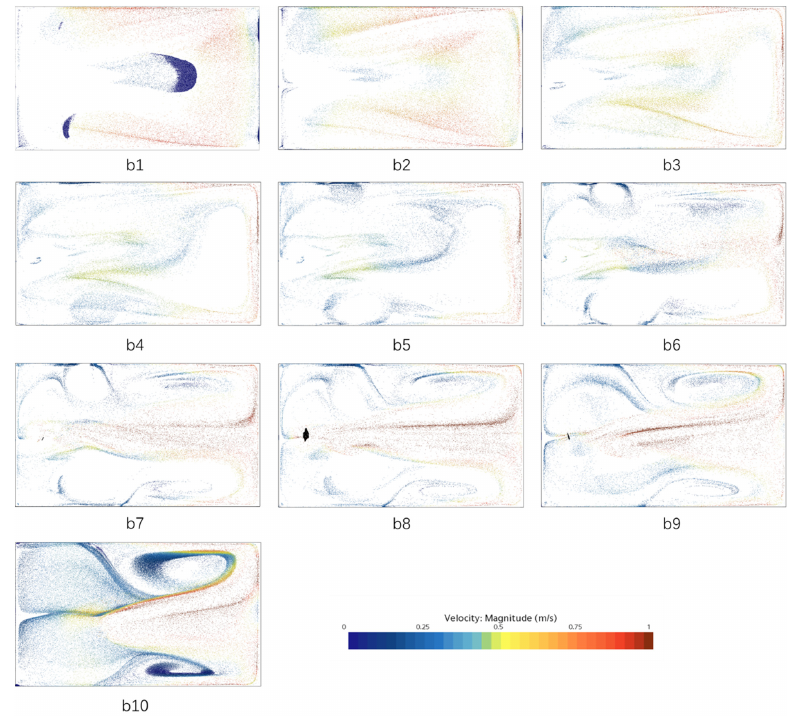
Figure 19. Location and velocity distribution of particles in b1~b10.